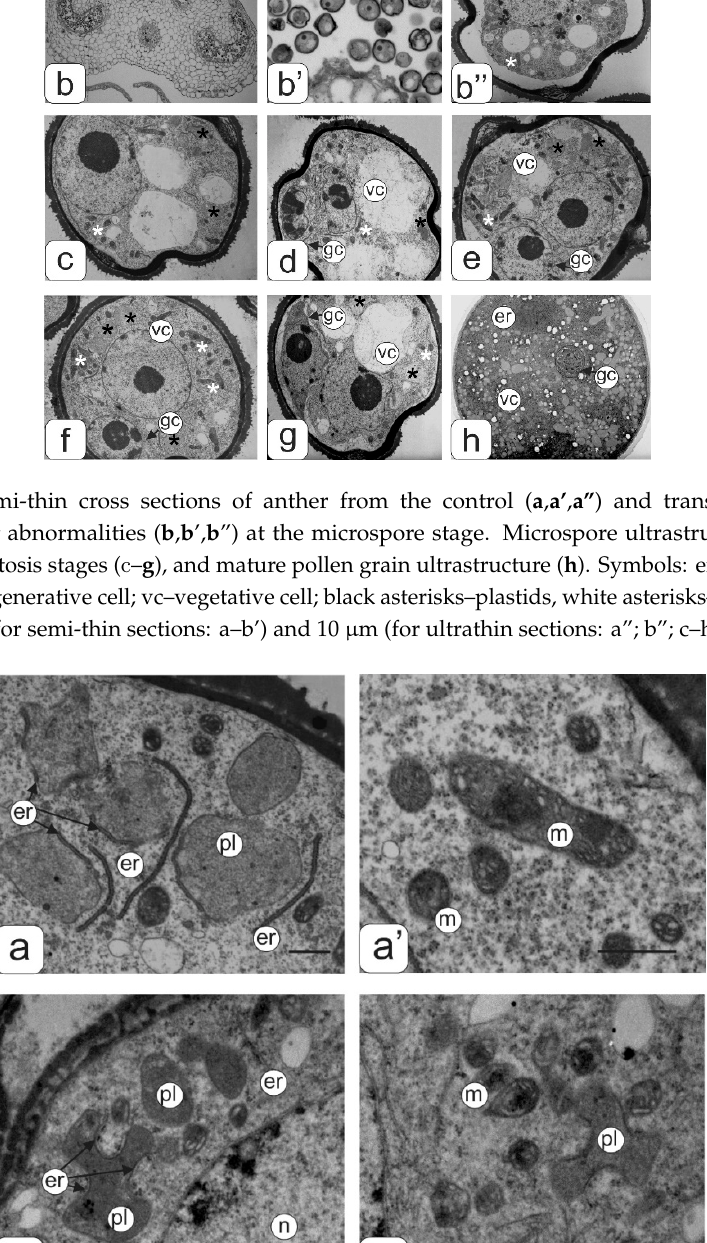
Figure 4. Cross-sections of anthers with various types of developmental abnormalities ( a – d ). Pollen sacs ( а ’– d ’) and microspore ultrastructure ( a’ ’– d’’ ) from these anthers. black asterisks—plastids,